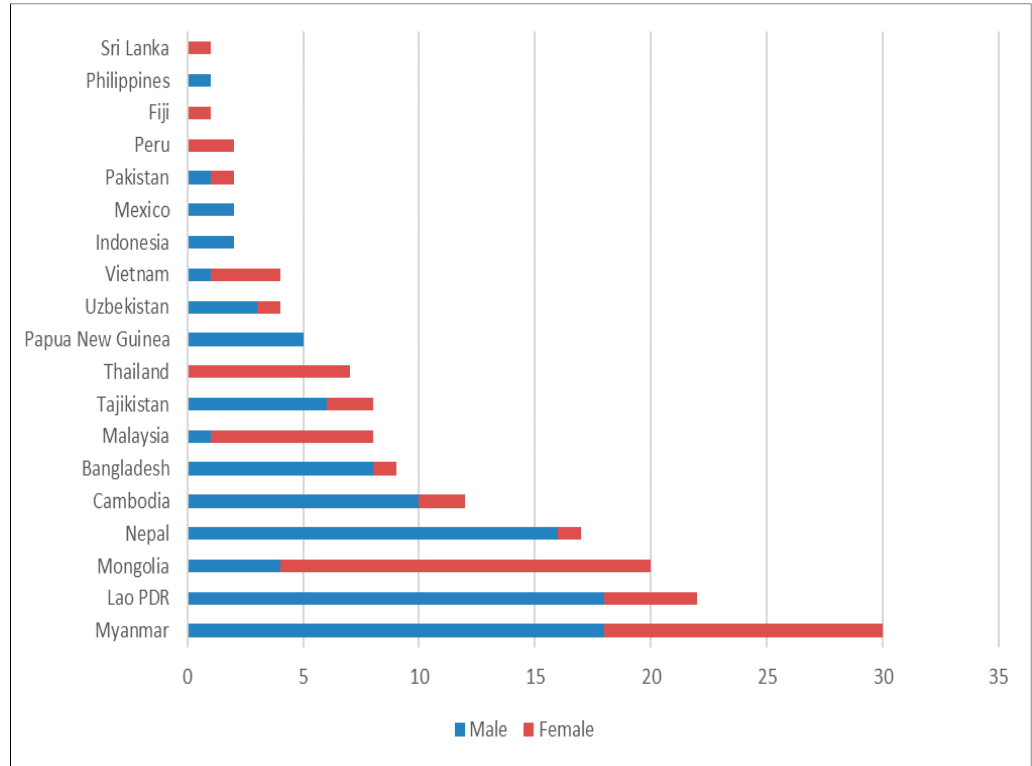
Figure 1. Nationality and gender of the APFNet Scholarship Program awardees 2010–2020 (number of students).